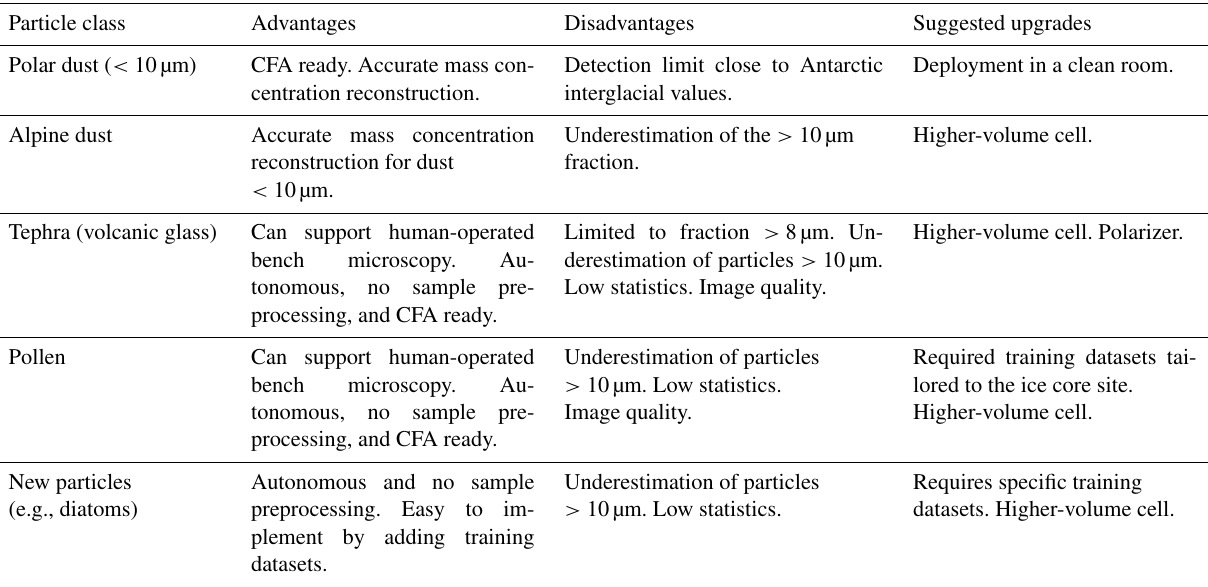
Table 6. Advantages, disadvantages, and suggested upgrades to the system presented in this